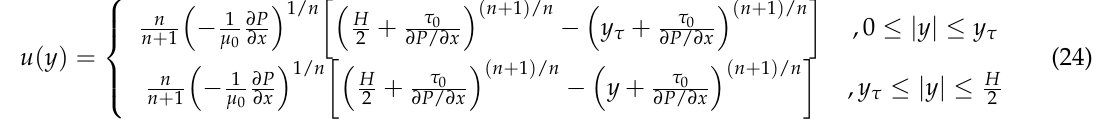
Figure 4. Distributions of the velocity component v at different directions: ( a ) velocity v -depth h , and ( b ) width W -velocity v.